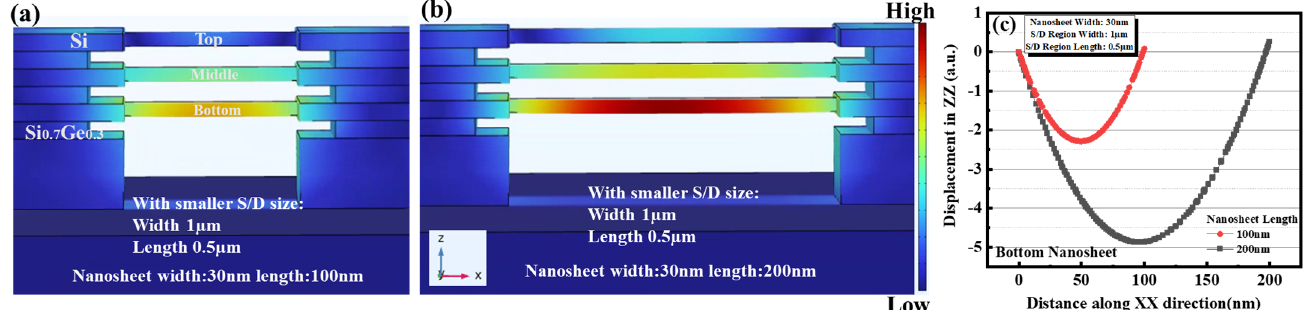
Figure 4. Different GAA Si nanosheet lengths ( a ) 100 nm and ( b ) 200 nm with smaller S/D size schematics of displacement mapping of the top, middle and bottom nanosheet in COMSOL (Si nanosheet width: 30 nm). ( c ) Extracted displacement of the bottom nanosheet in ( b ) along XX direction.